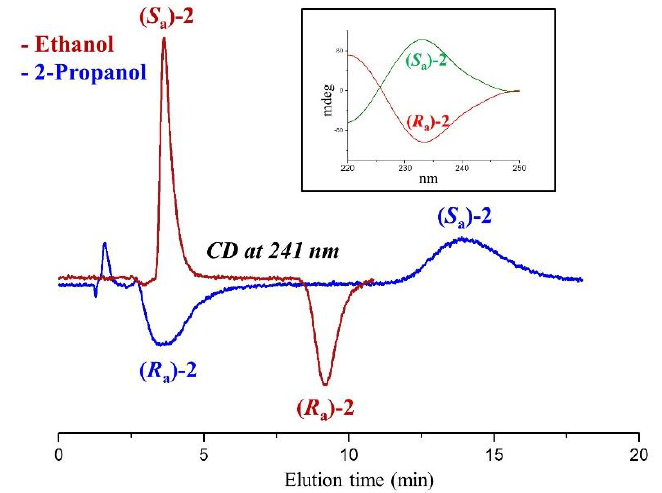
Figure 3. Typical chromatograms illustrating the differences in enantiomer elution order of 2 using pure ethanol and 2-propanol as mobile phases. Chromatographic conditions: column, Chiralpak AD-3 (100 mm × 4.6 mm, 3 µ m); flow rate, 1 mL/min; temperature, 25 ◦ C; detection, CD at 241 nm. 2-PrOH: 2-propanol; 1-PrOH: 1-propanol, EtOH: ethanol; MeOH: methanol. Inset: CD spectra of enantiomers of 2 .